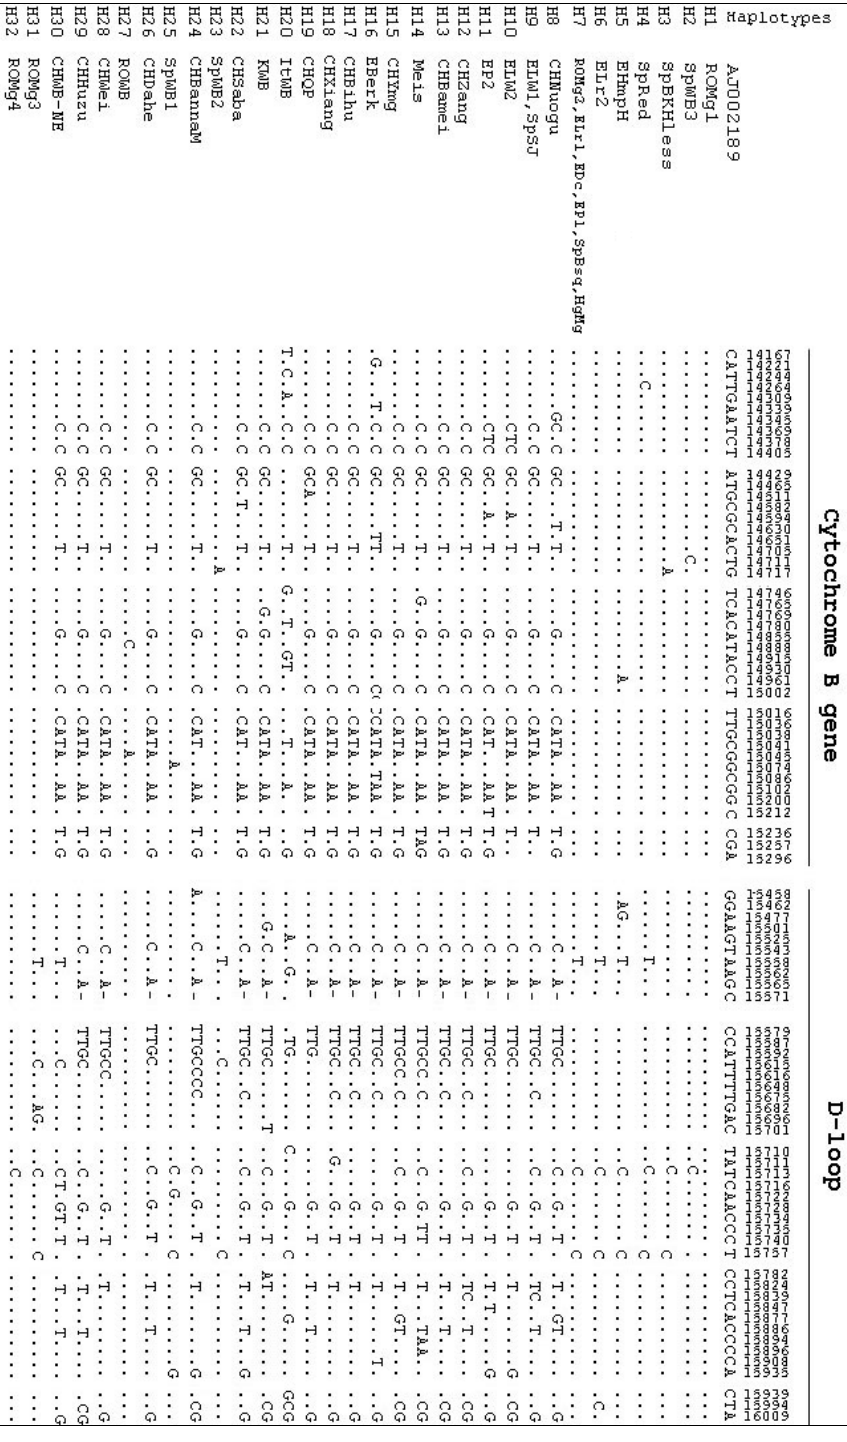
Figure 1. Haplotypes and variable sites in the D-loop region (between nucleotides 15,455 and 16,068) and cytochrome b gene in 24 swine breeds, 5 Wild Boar populations and the reference sequence (GenBank AJ002189). The numbers represent the position occupied in the sequence. Identical sites are indicated by the symbol “·” and the deletions with